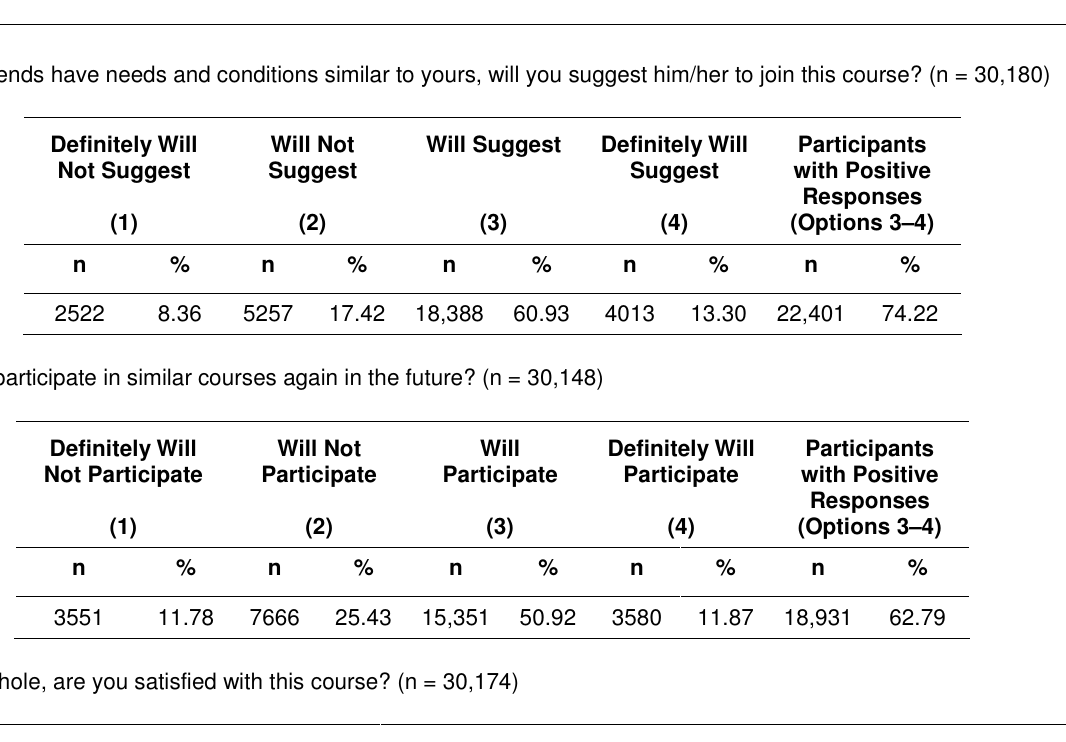
Other Aspects of Subjective Outcome